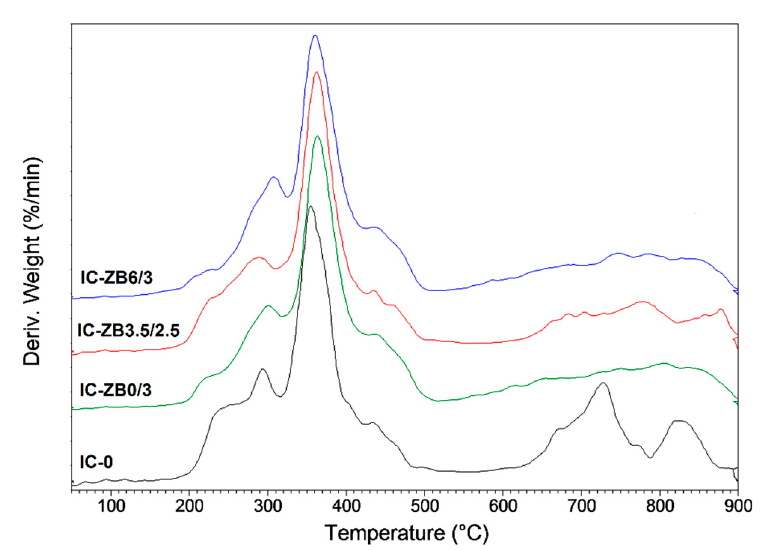
Figure 8. DTG curves for the selected intumescent coatings with various zinc borates.